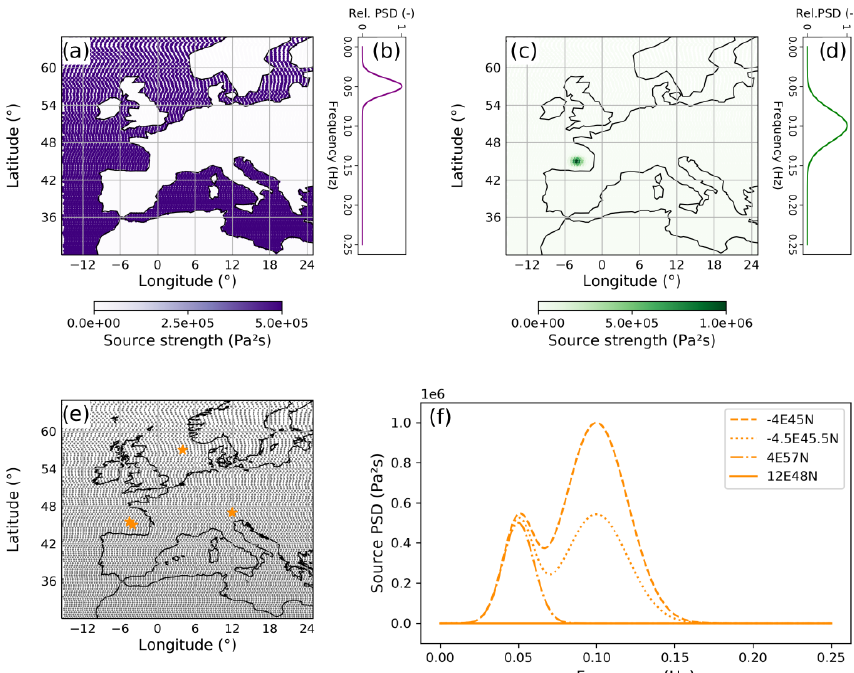
Figure 1. Illustration of noise source model parametrization. The upper panels show spatial source distributions (a, c) with different spec- tra (b, d) . Note the difference in maximum amplitudes. (Similar figures can be reproduced by following the Jupyter Notebook tutorial for noisi ). Panel (e) shows the grid on which source spectra are defined; power spectral densities, corresponding to the term S nm of Eq. (4) for the grid locations ξ marked by yellow stars, are shown in (f) . These are the superposition of spectra (b) and (d) , with spatially varying amplitudes specified by distributions (a) and (c) ,